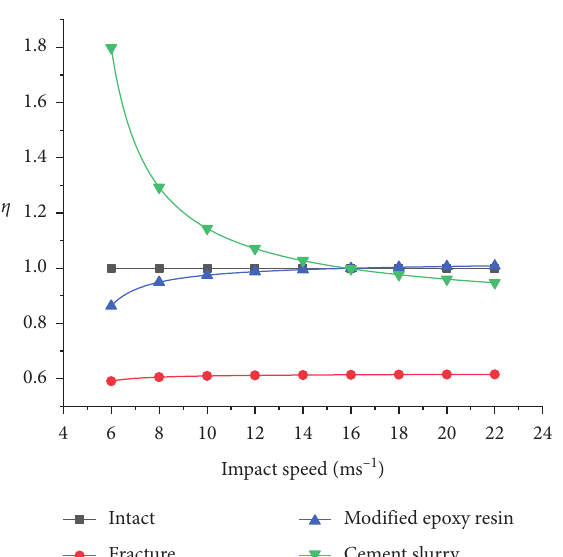
Figure 7: Impact speed-dynamic specific strength.